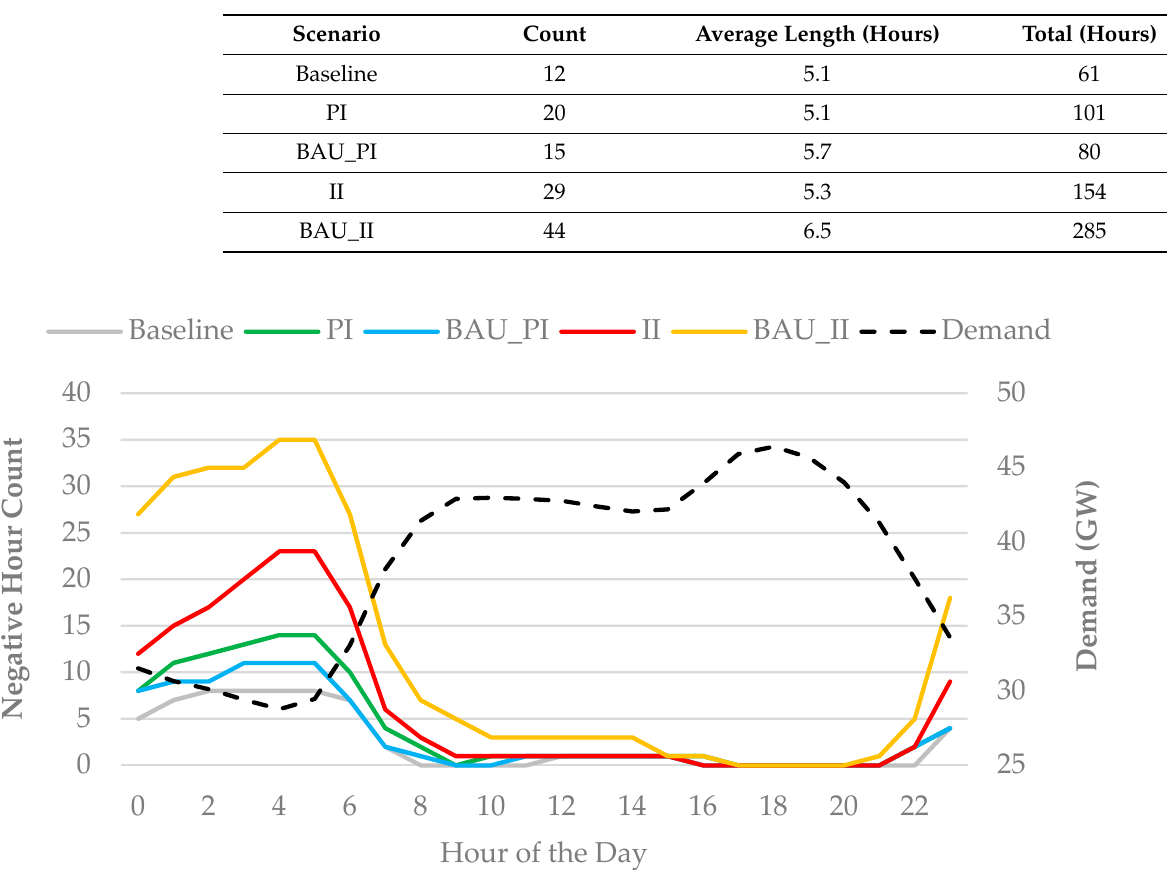
Figure 11. Occurrences of negative price hours throughout the day compared with average UK demand.